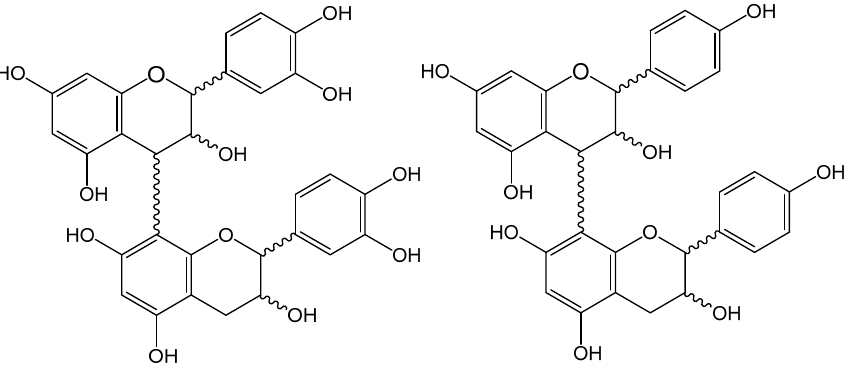
Figure 1. Procyanidin (PC) and propelargonidin (PP) general chemical structures.